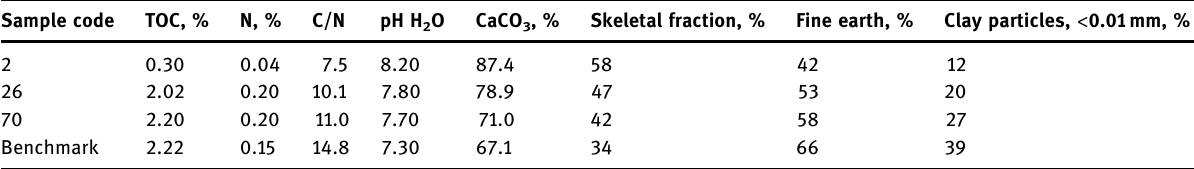
Table 1: Chemical properties of topsoil humus organo - mineral layers Sample code